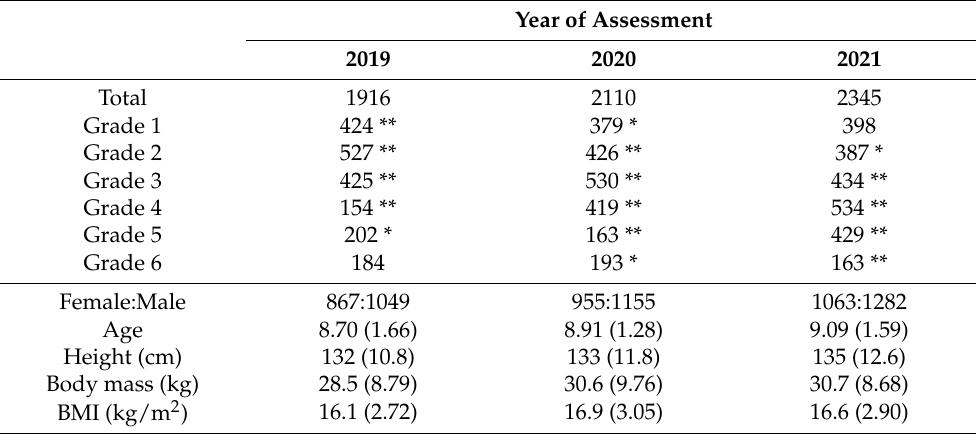
Table 2. Basic demographic information for the participants in three measurement timepoints (year of assessment).